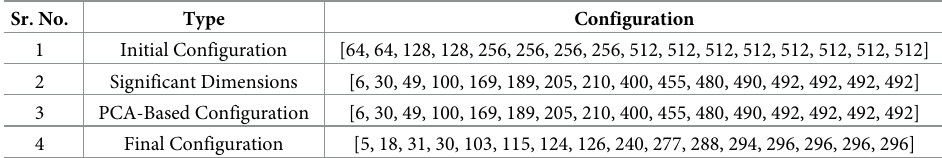
Table 9. Configuration of VGG-19 on ILSVRC2017.